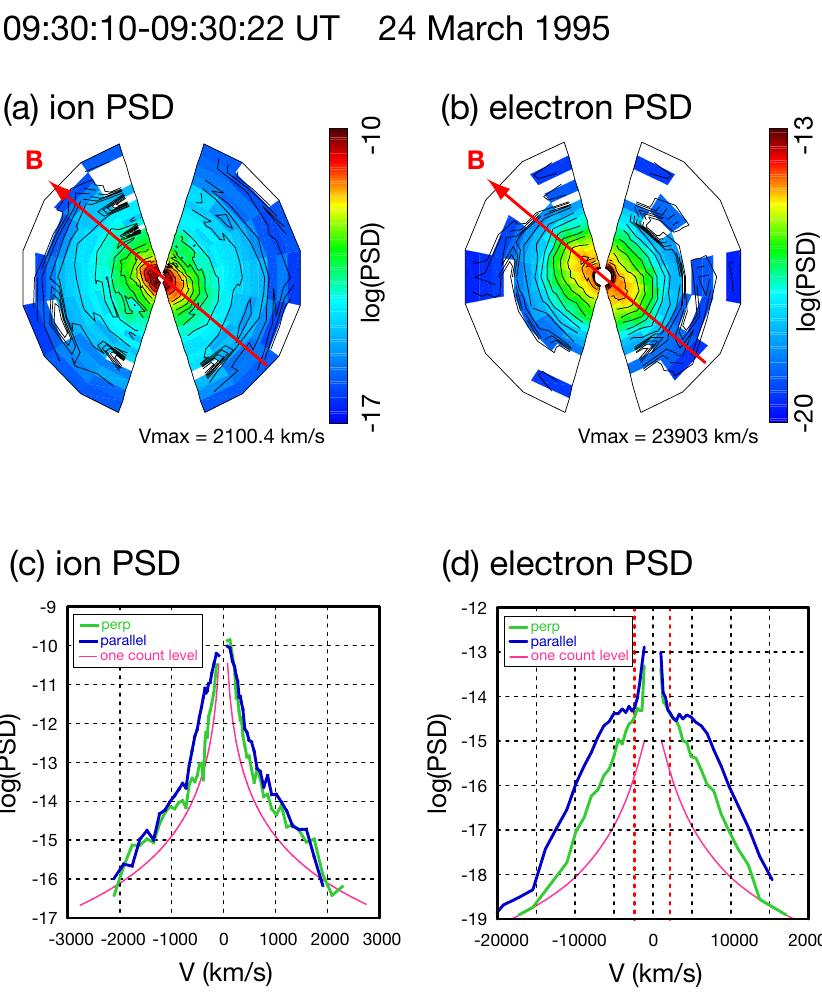
Fig. 2. Panel (a) shows a cut of ion PSD for the 12-s interval 09:30:10–09:30:22 UT on 24 March 1995, in the plane that includes the magnetic field. The field direction is shown by the red arrow. Panel (b) shows a cut of electron PSD for the same interval and in the same plane as shown in the left panel. Panels (c) and (d) show 1-D cuts of ion and electron PSDs in the direction perpendicular and parallel to the local magnetic field, which are shown by green and blue lines, respectively. A couple of vertical red broken lines in Panel (d) correspond to the lowest energy used for fitting